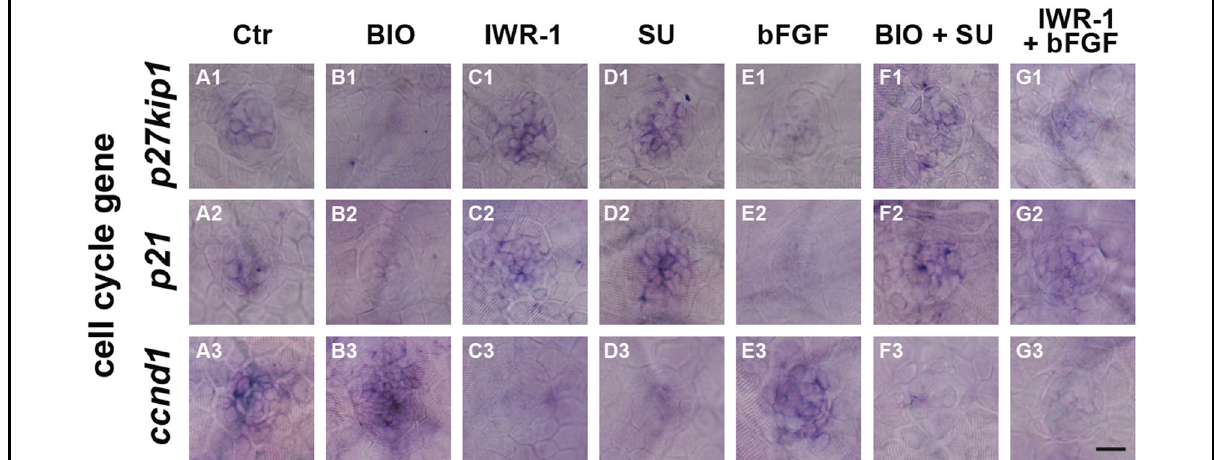
Fig. 5 Whole-mount in situ hybridization of p27 , p21 , and ccnd1 following regulation of Wnt and FGF signaling. A1 – G3 In situ hybridization of p27 ( A1 – G1 ) p21 ( A2 – G2 ) and ccnd1 ( A3 – G3 ) following BIO ( B1 – B3 ), IWR-1 ( C1 – C3 ), SU5402 ( D1 – D3 ), bFGF ( E1 – E3 ), BIO + SU5402 ( F1 – F3 ), and IWR-1 + bFGF ( G1 – G3 ) treatments. Scale bar in G3 = 30 μ m for A1 –